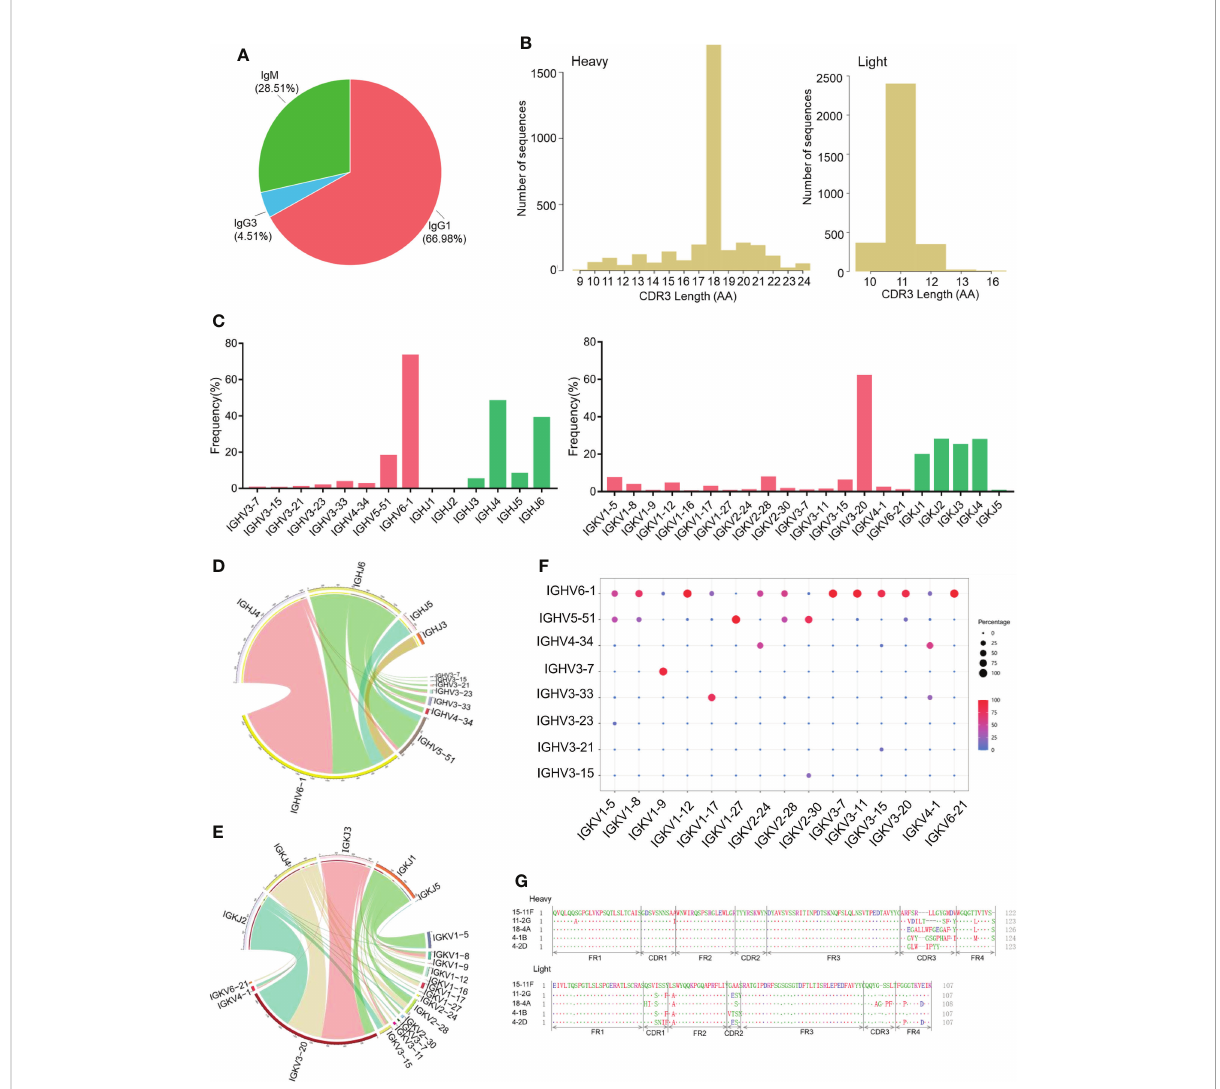
FIGURE 2 Antibody repertoire features of RBD-reactive hybridoma cells derived from CAMouse HG mice. (A) Isotype usage in single-cell repertoire sequencing data of hybridoma clones speci fi cally recognized SARS-COV-2 RBD. (B) CDR3 AA lengths of heavy and light chains. (C) Human V and J genes of heavy- and light-chain utilization. Circos plots comparing VJ gene association of heavy (D) and light chains (E) . VJ combinations are linked based on their relative frequency. (F) Paired antibody repertoire. Circle size and color correspond to the number of heavy and light chains present. (G) Amino acid sequence alignment of the fi ve SARS-COV-2 neutralizing mAbs isolated from CAMouse HG